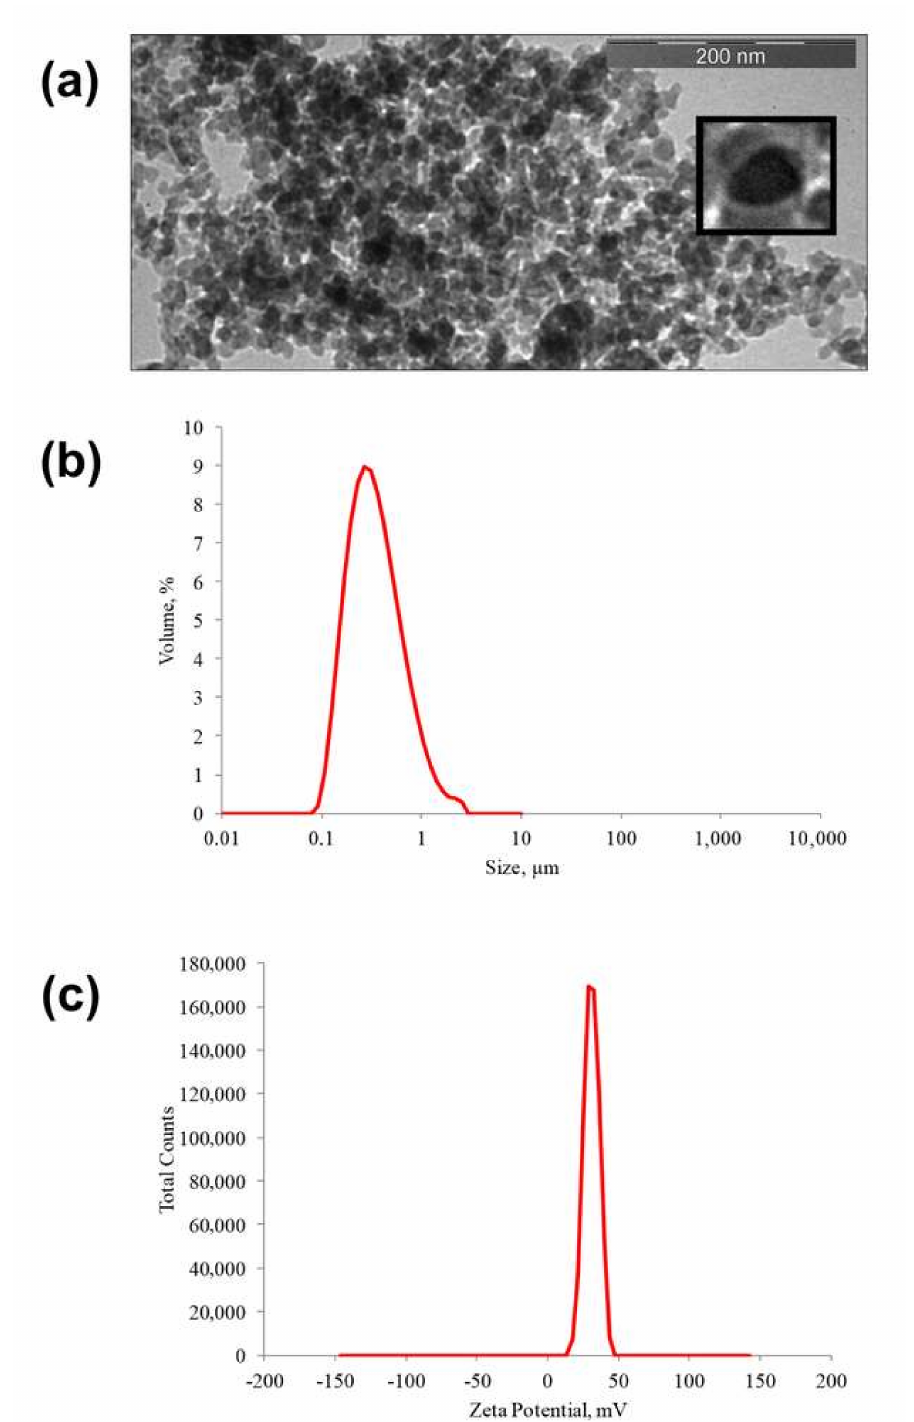
Figure 10. Physical properties of the obtained nanoobject “core–shell” structure: ( a ) TEM photograph of the obtained multilayer nanostructures; ( b ) distribution of the hydrodynamic diameter; ( c ) zeta